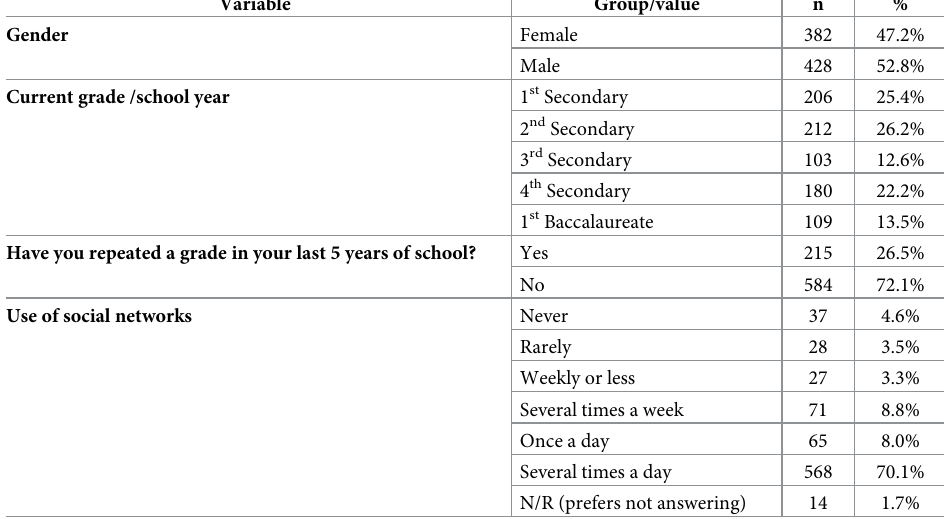
Table 1. Sociodemographic characteristics of the study